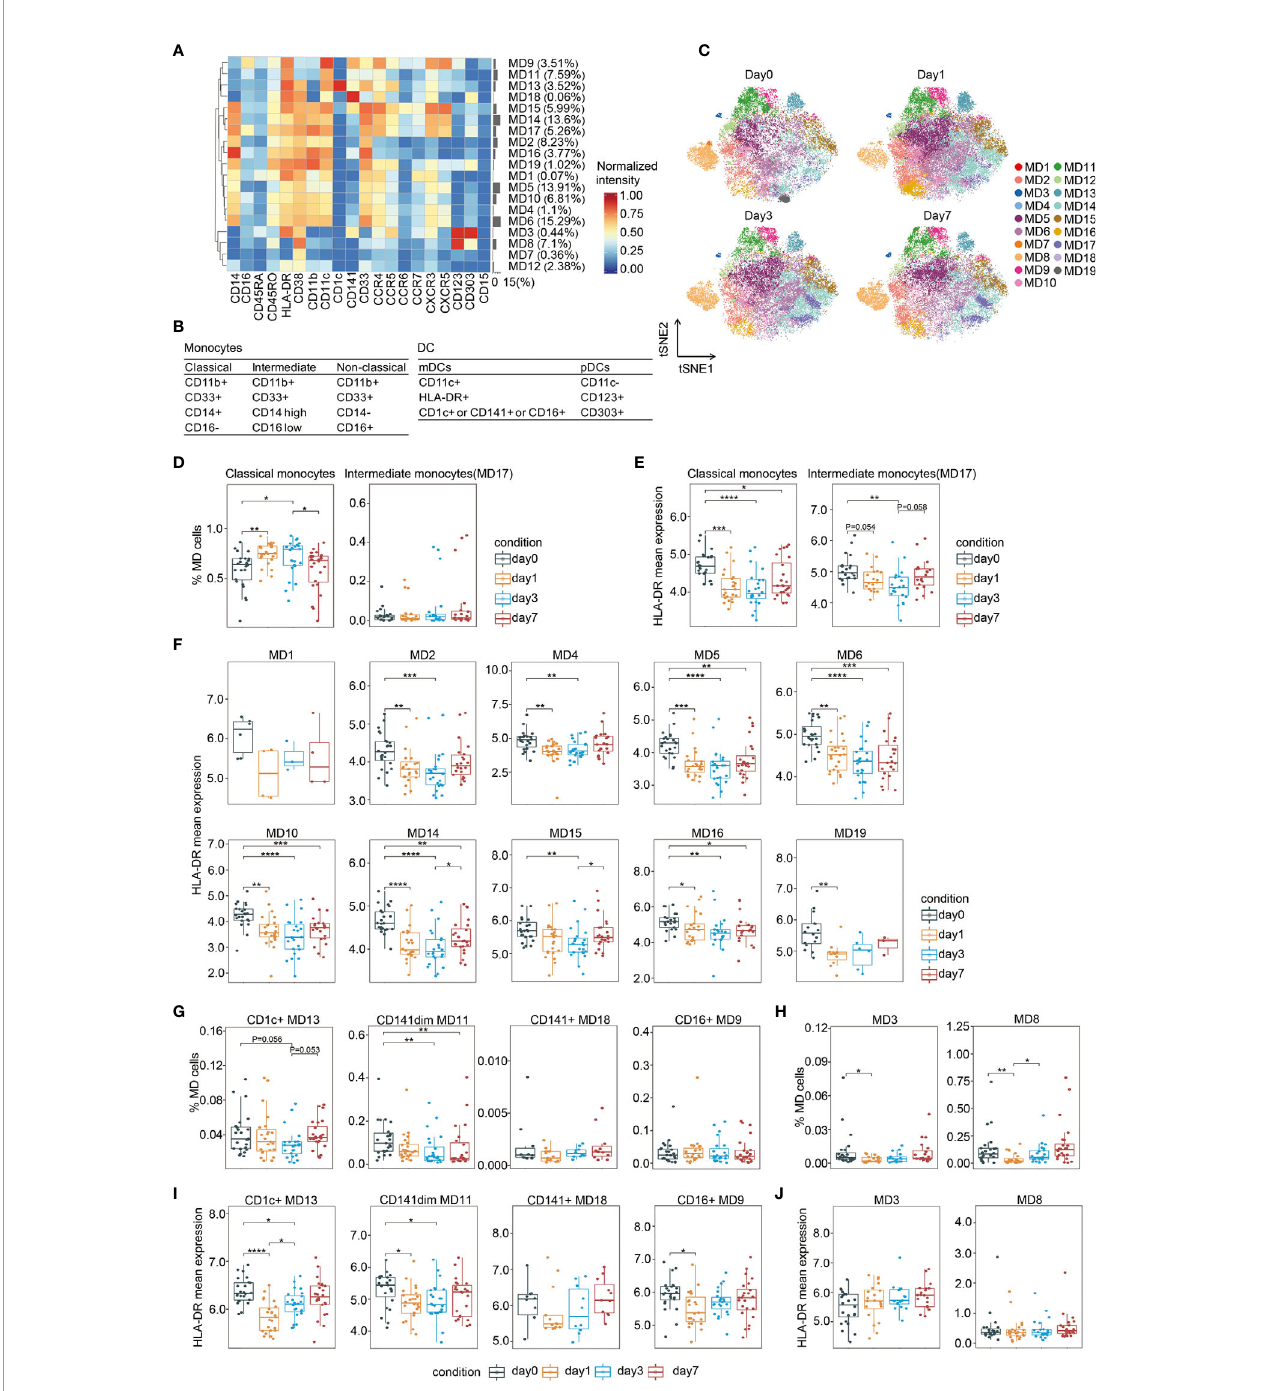
FIGURE 4 | Characterization of perioperative monocytes and DCs. (A) Heatmap showing normalized expression of the markers for the 19 monocytes and DC clusters. Clusters are grouped by marker expression patterns. The cluster numbers and relative frequencies are displayed on the right. (B) Surface marker combinations used to identify monocytes and DC subsets. (C) FIt-SNE of monocytes and DCs colored by PhenoGraph clusters at different time points. (D) Boxplots showing the frequencies of the classical and intermediate monocytes during the perioperative period. (E) Boxplots showing the mean expression levels of HLA-DR in monocytes during the perioperative period. (F) Cluster-speci fi c analysis of HLA-DR expression in monocytes shown by boxplots. (G, H) Boxplots showing the frequencies of the mDCs (G) and the pDCs (H) during the perioperative period. (I, J) Boxplots showing the cluster-speci fi c mean expression of HLA-DR in mDCs (I) and in pDCs (J) during the perioperative period. *p < 0.05, **p < 0.01, ***p < 0.001, ****p < 0.0001 by Krustal-Wallis analysis with post-hoc Dunn test. P-value adjusted with the Benjamini-Hochberg